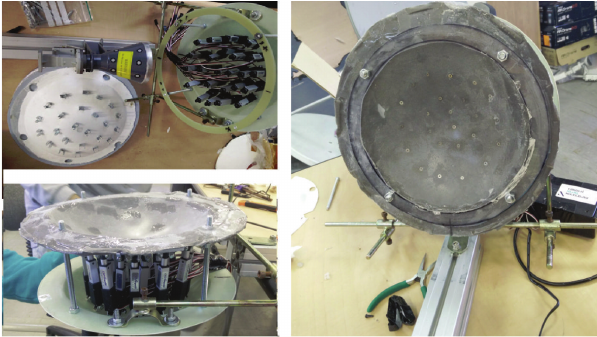
Figure 4: The advanced model of the dynamic subreflector. It was mostly made of complex materials, and each linear actuator was placed and locked to the surface allowing a tight structure while maintaining the flexibility of the dynamic RF